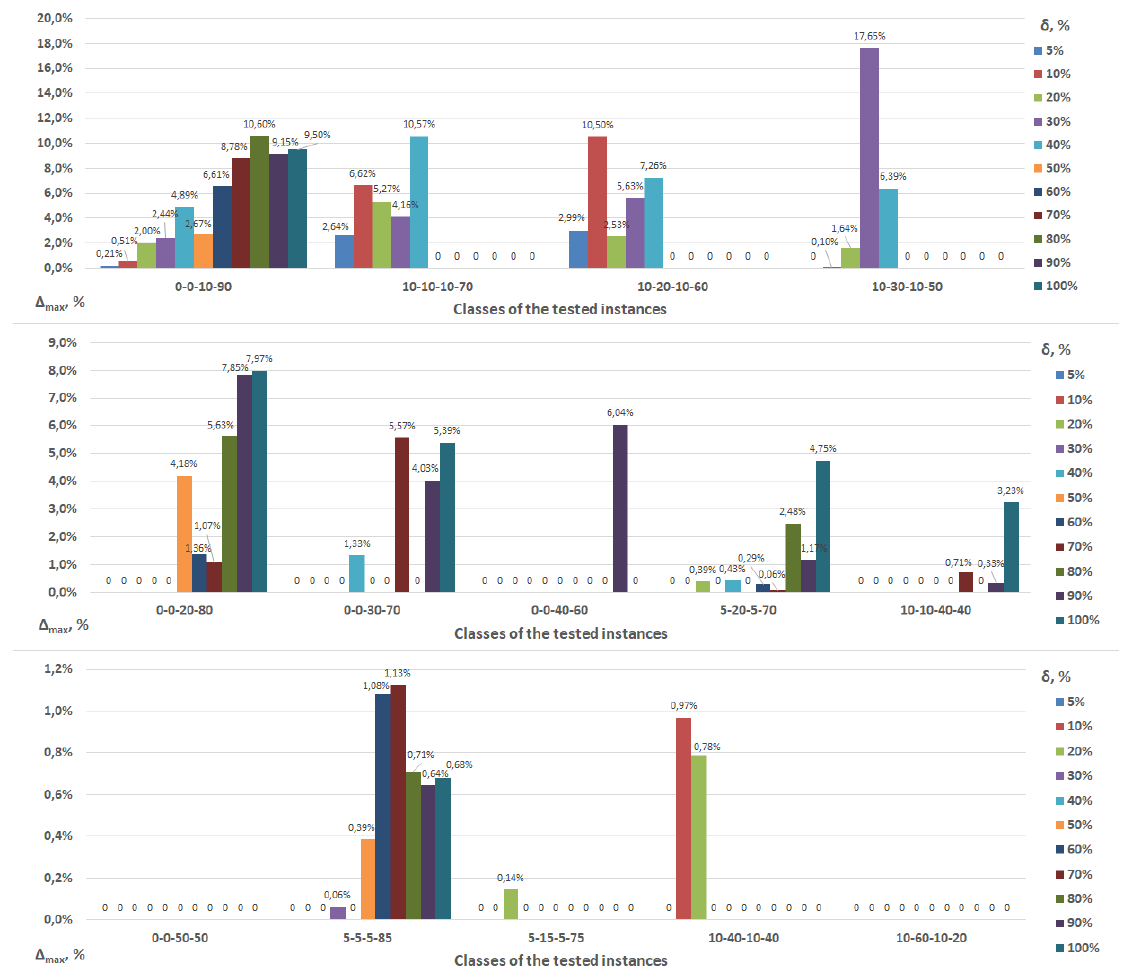
Figure 8. Maximal errors ∆ max for the tested instances with a gamma